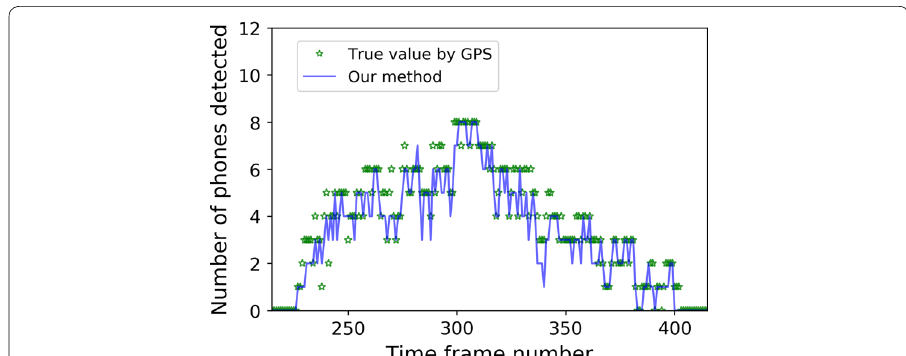
Fig. 14 Performance of our method w.r.t. ground truth provided by the GPS locations of phones